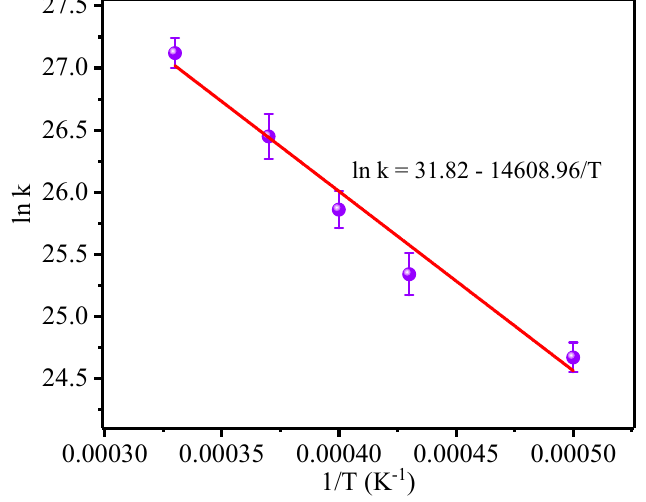
Figure 4. The number of meta-aramid fiber molecules at different temperatures.